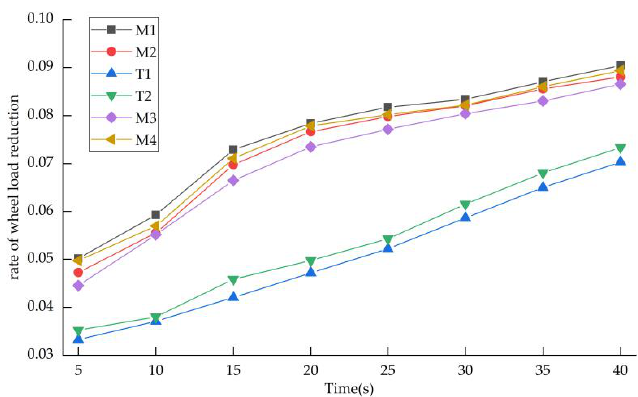
Figure 7. Rate of wheel load reduction.